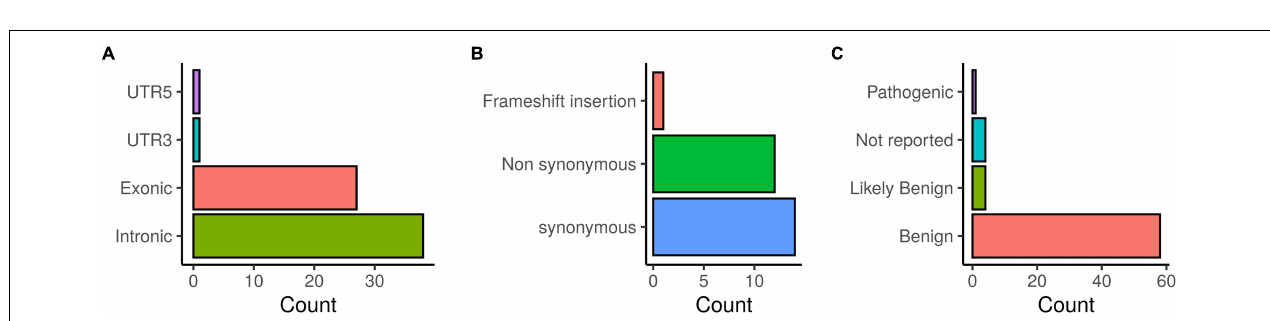
FIGURE 1 | Familial Pedigrees of BRCA1 and RAD50 mutations carriers. Available age at diagnosis of breast cancer cases is indicated between brackets. For some cases, only age at death was available and is indicated in square brackets. BOC, Breast and ovarian cancers; CBC, Contralateral breast cancer; IBC, Inflammatory breast cancer; OC, ovarian cancer. Black boxes mean breast cancer and half black boxes mean other cancer types.